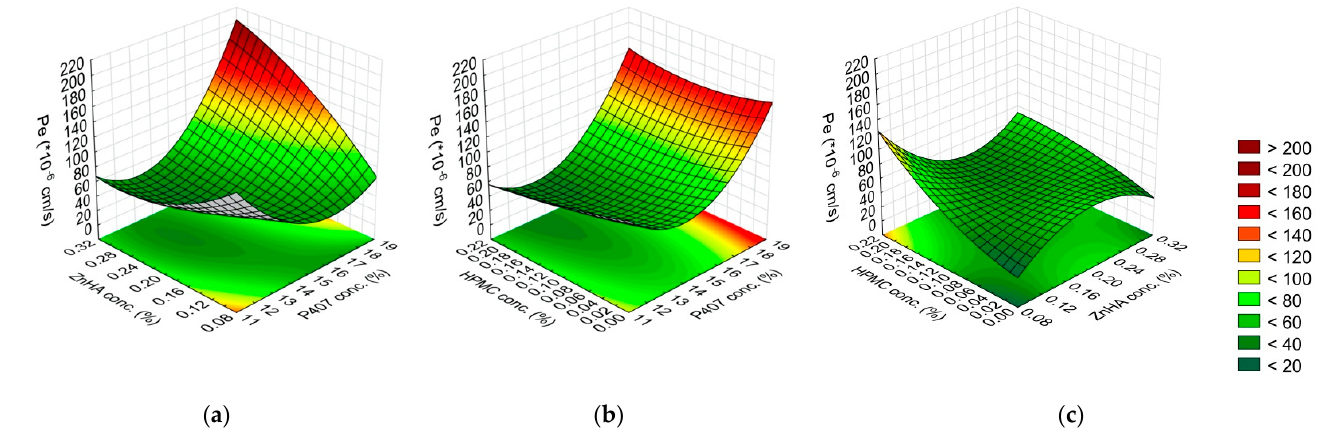
Figure 8. Effect of the composition on the permeability (Pe): ( a ) P407 and ZnHA concentrations, ( b ) P407 and HPMC concentrations, ( c ) ZnHA and HPMC; (the 3rd factor is at 0 level in each case). Based on the results of the experiments, some compositions (S6, S9, S10, S13, S17, S18) with desired rheological and mucoadhesive characteristics were chosen for further statistical analysis. In vitro drug release and corneal-PAMPA parameters of these samples were compared with DXM suspension (DXM susp.), and CD-DXM solution without polymers was also measured (Figure